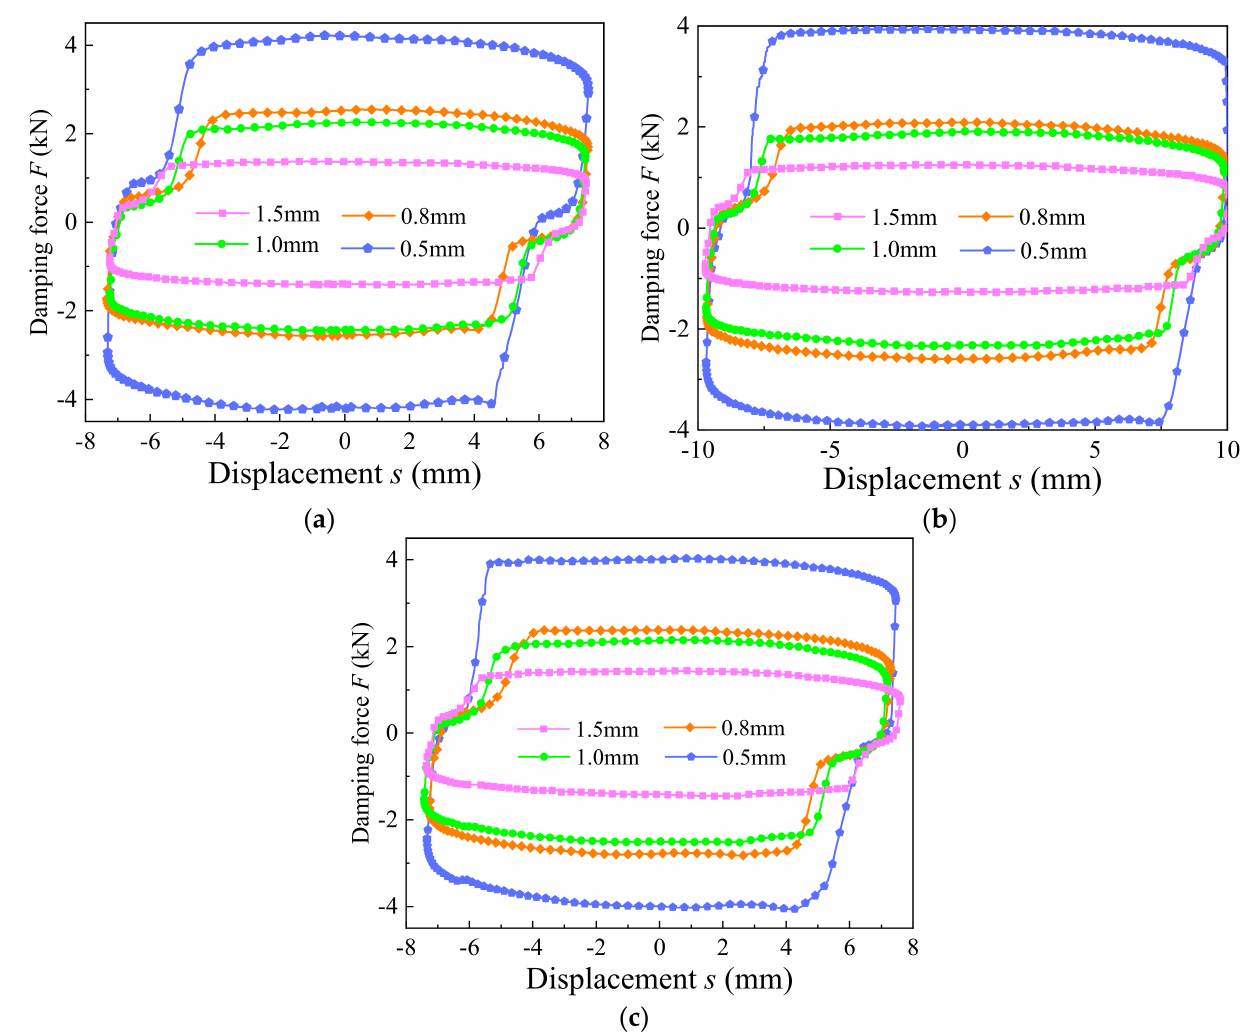
Figure 21. Comparison of damping force of the MR valve controlled cylinder system with different damping gaps: